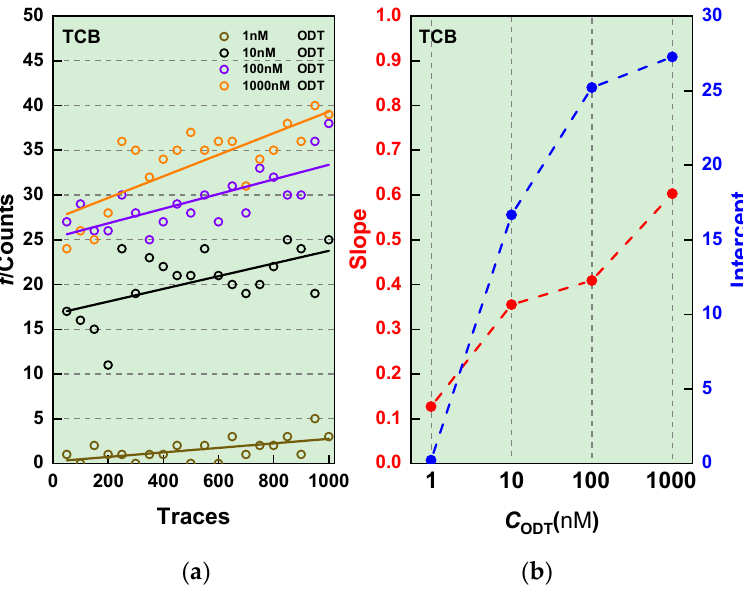
Figure 5. ( a ) Time-course change in the ODT junction formation probability f . Solid lines are linear fitting to the plots. ( b ) The slope and intercept of the linear fits in ( a ).